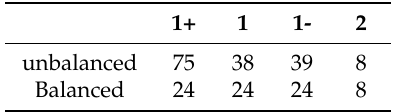
Table 6. Training sample size of tree vitality classification by MLS data.